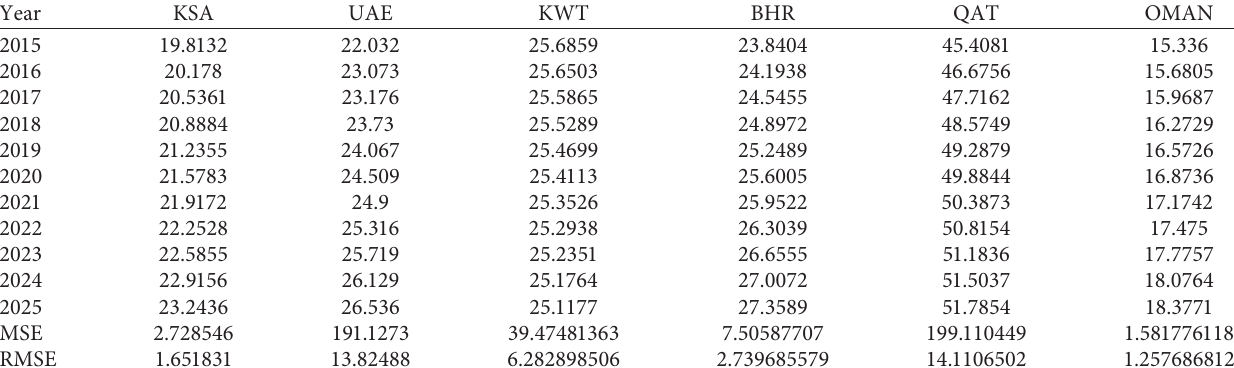
Table 1: Predicted value of CO 2 emissions (metric tons per capita) using the ARIMA (1,1,1) model and accuracy measures.